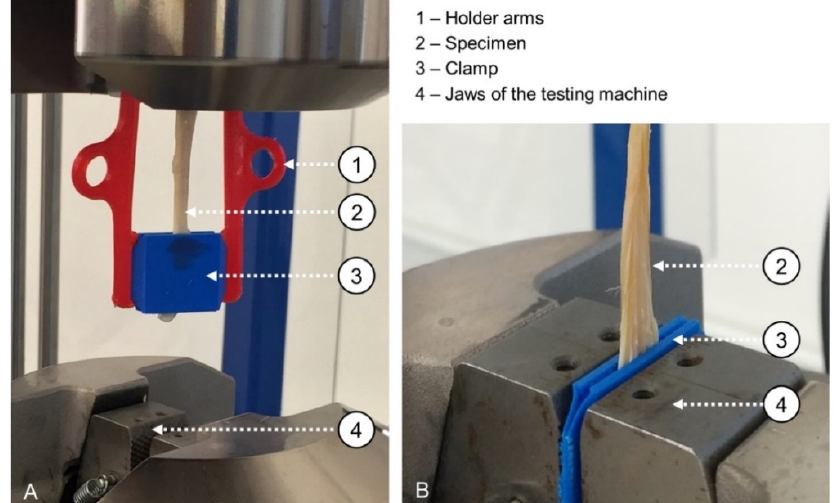
Figure 2. Specimen mounting in the testing machine ( A ) using clamps on each side and flexible holder arms to facilitate accurate placement with a consistent testing length and ( B ) setup ready for mechanical testing with 3D-printed clamps and a clamped tendon placed between the closed exter- nal jaws.